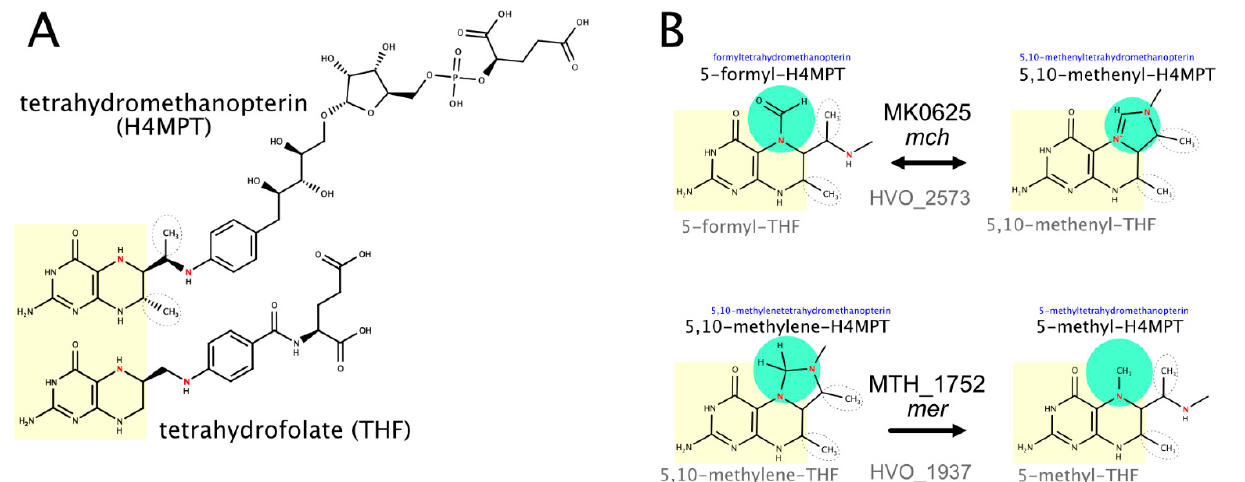
Figure 2. The structure of the C1 coenzymes tetrahydrofolate and methanopterin and two enzymes that act on the attached C1 compound. ( A ) The structures of tetrahydromethanopterin (top) and tetrahydrofolate (bottom) illustrate the similarities and differences between these C1 coenzymes. The common pteridine-based ring system is highlighted in yellow, and the initial biosynthesis step that generates this ring system is catalyzed by homologous enzymes (topic (b)). Two methanopterin-specific methyl groups are outlined by dashed ovals. N5 and N10, which are involved in the binding of the C1 compound, are colored red. ( B ) Two enzymatic reactions that alter the oxidation level of the C1 compound are illustrated. The methanogenic and haloarchaeal enzymes are homologous, even though they use distinct C1 coenzymes (topic (c)). It should be noted that MTH-1752 uses coenzyme F420 (not illustrated, Section 3.4, topic (c)), and this might also hold true for HVO_1937. Table 5. Proteins with open annotation issues and their Gold Standard Protein homologs (Section 3.5). For a description of this table, see the legend to Table 1.